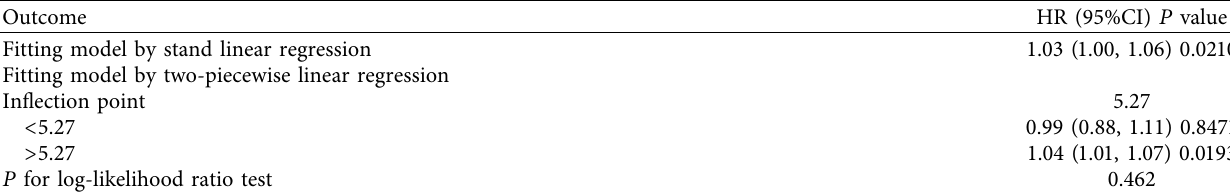
Outcome Fitting model by stand linear regression